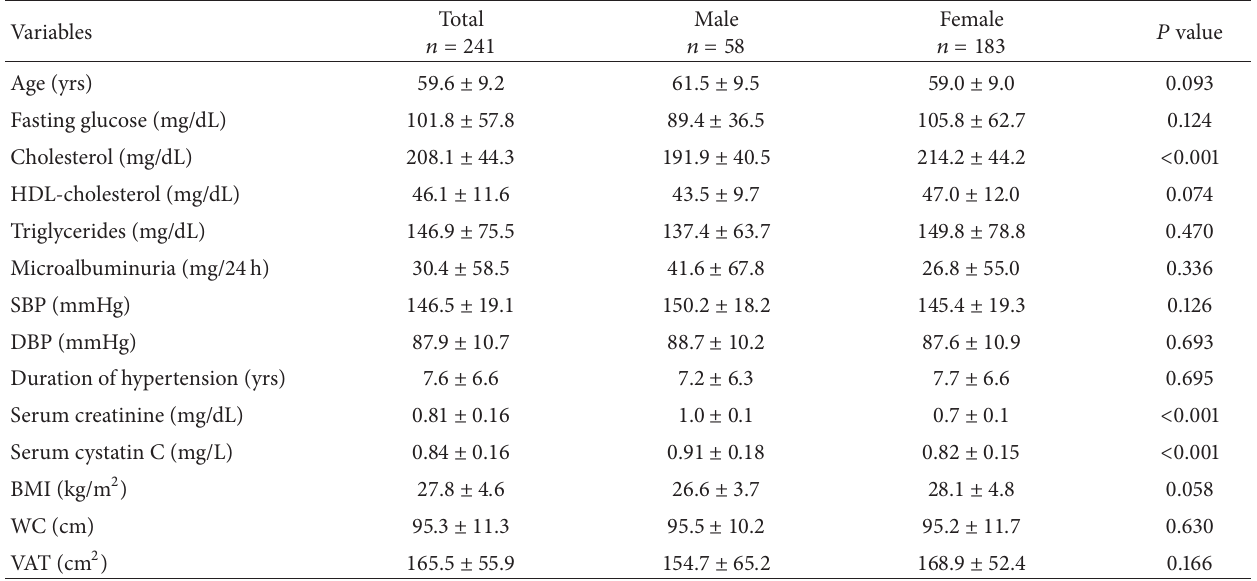
Table 1: Clinical, biological, and anthropometric characteristics of the study participants by